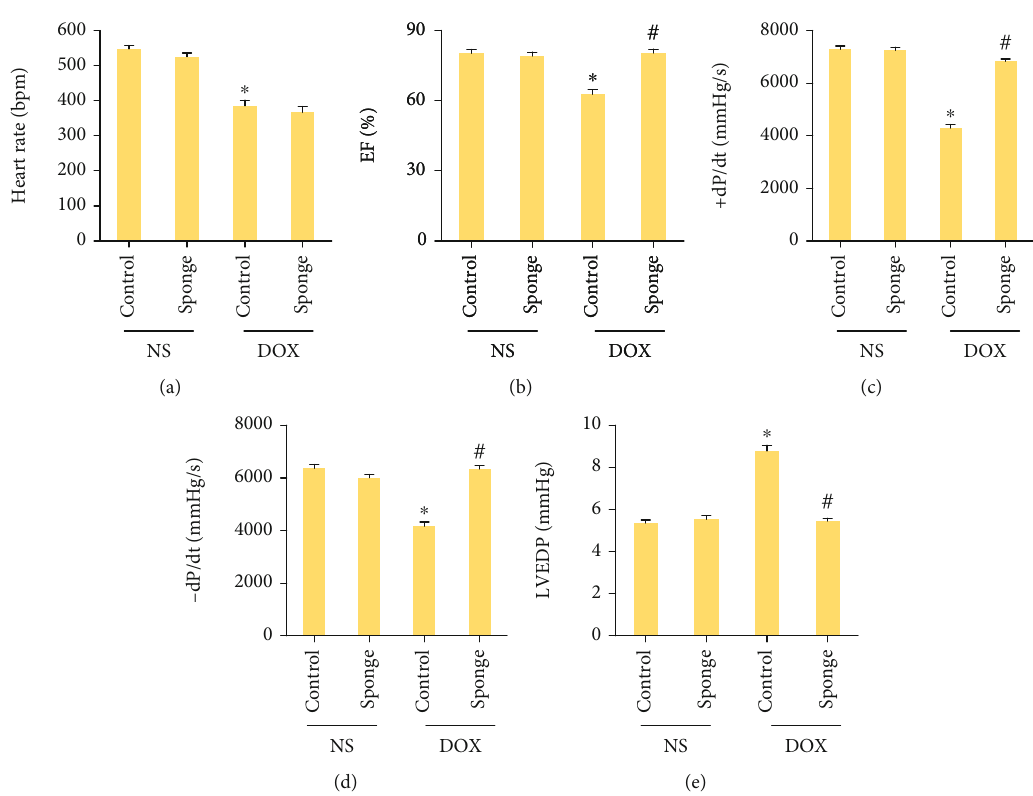
Figure 3: miR-128-3p inhibition improved cardiac function in DOX-treated mice. (a) Heart rate in the indicated groups ( n = 8 ). (b) Ejection fraction in the indicated groups ( n = 8 ). (c, d) ± dP/dt in the mice ( n = 8 ). (e) LVEDP in the indicated groups ( n = 8 ). Data are expressed as mean ± SEM . ∗ P < 0 : 05 vs. NS/control group; # P < 0 : 05 vs. DOX/control